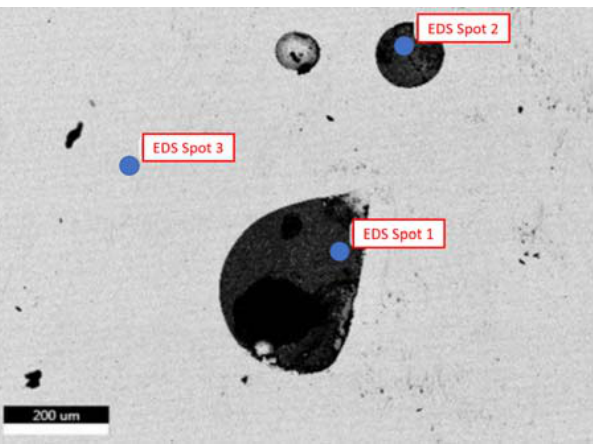
Figure 12. SEM image of specimen No. 5 with marked regions of compositional analysis.